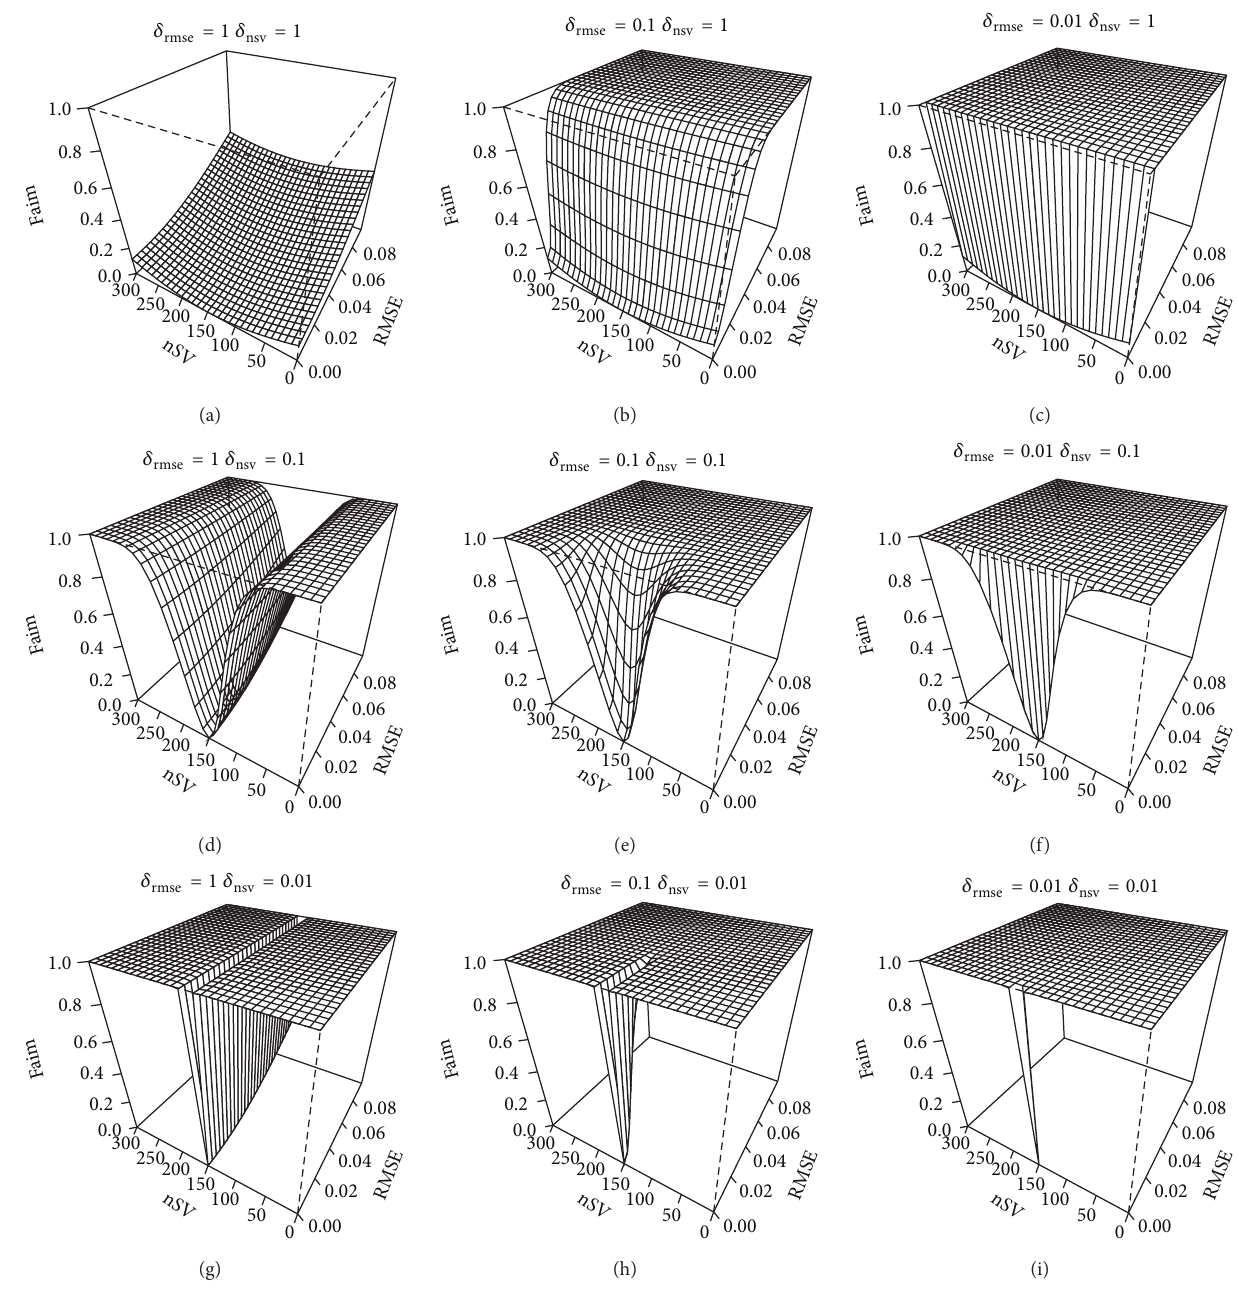
Figure 4: The shape of the aim function and its dependence on aim function